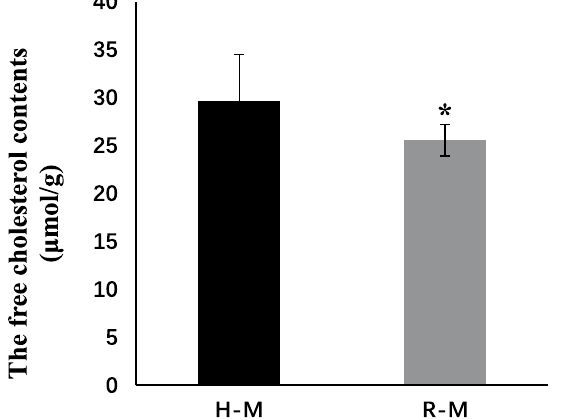
Figure 5. Comparison of cholesterol abundances between H-M and R-M based on a Free Cholestenone Content Assay Kit. * P <